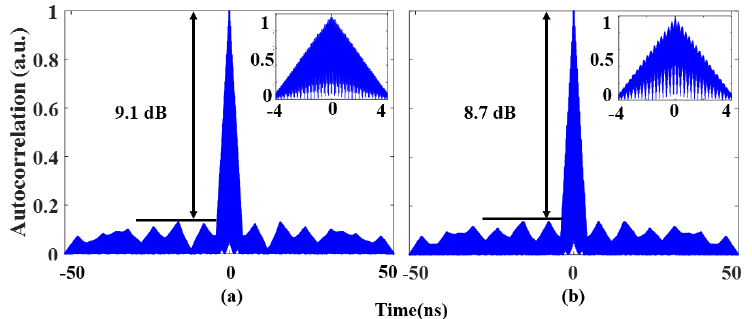
Figure 9. Autocorrelation results of binary phase-coded signals in ( a ) fundamental carrier frequency mode and ( b ) doubled carrier frequency mode. The insets show zoomed–in views of the corresponding autocorrelations.